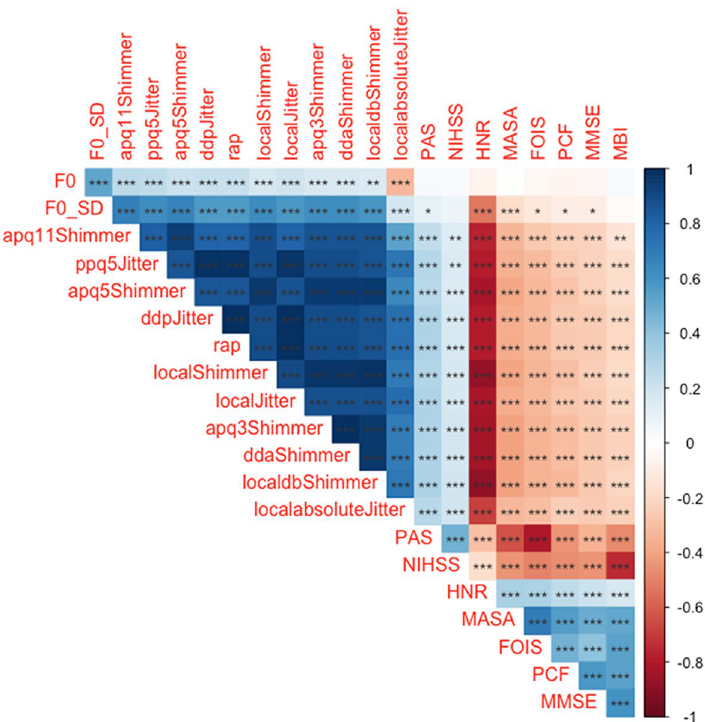
Figure 2. Correlation analysis between the Praat features and the clinical parameters. The correlation graph shows that nearly all the voice features showed significant association with the clinical parameters, especially with those related to swallowing, and peak cough flow values. An exception was observed with the fundamental frequencies, which failed to show any association with the clinical parameters. * p < 0.05; ** p < 0.01; *** p < 0.001. HNR harmonic to noise ratio, F0 fundamental frequency, MBI modified barthel index, NIHSS national institutes of health stroke scale. F0 fundamental frequency, SD standard deviation, APQ amplitude perturbation quotient, PPQ period perturbation quotient, RAP relative average perturbation, PAS penetration-aspiration scale, NIHSS national institutes of health stroke scale, HNR harmonic to noise ratio, MASA mann assessment of swallowing